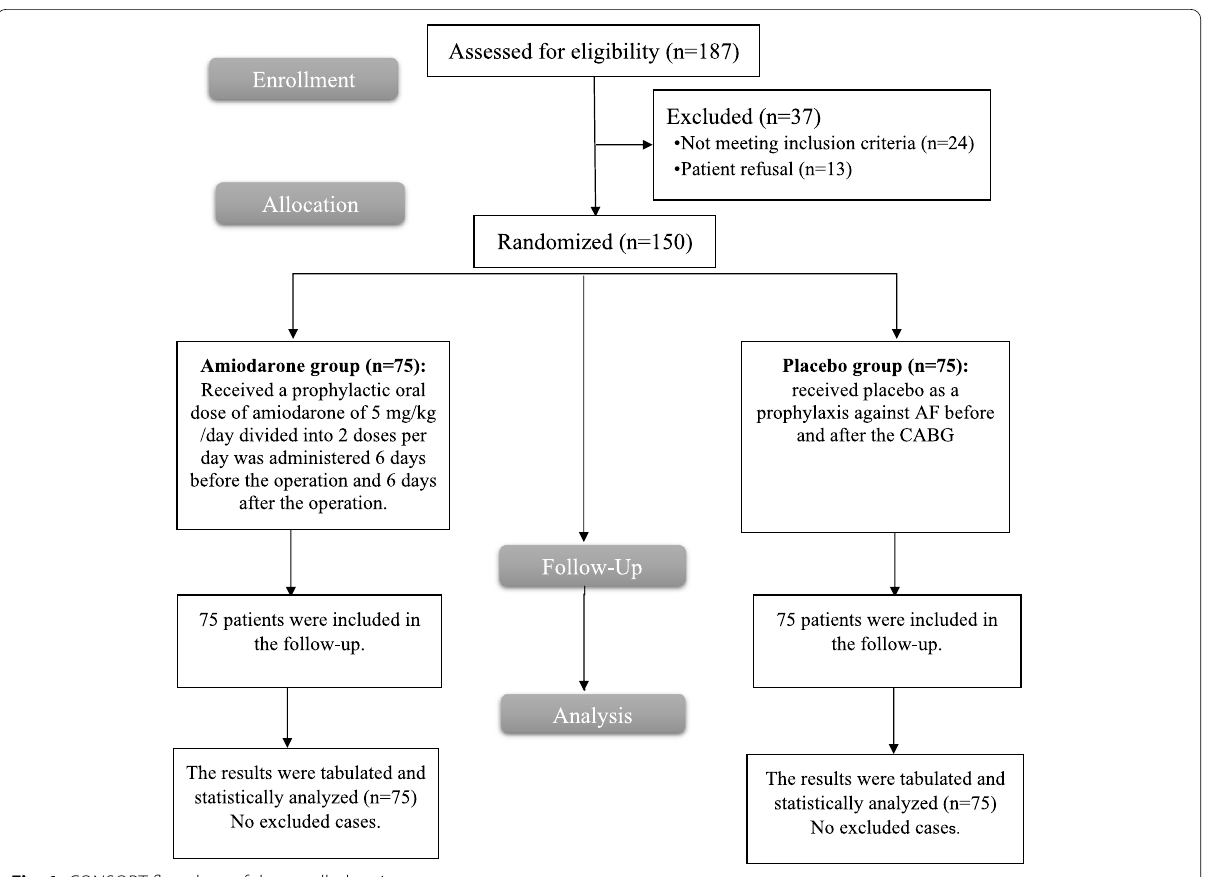
Fig. 1 CONSORT flowchart of the enrolled